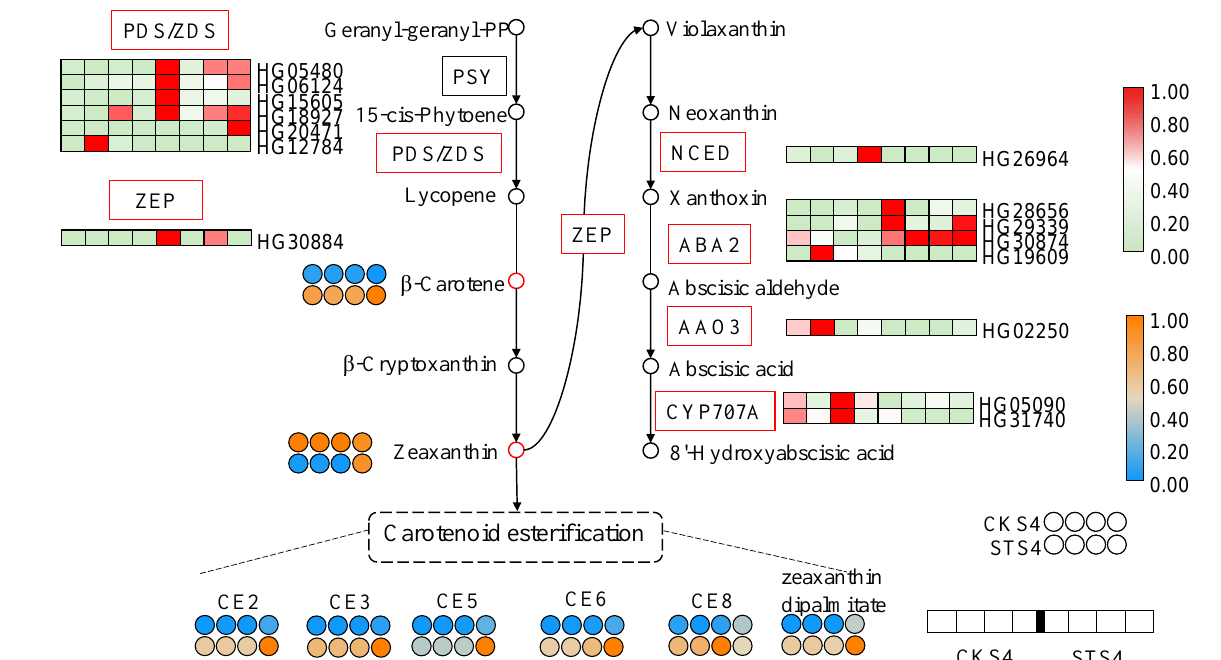
Figure 6. Differentially expressed genes (DEGs) and accumulated metabolites (DAMs) related to carotenoid biosynthesis and metabolism. Rectangle and circle cells indicate the DEG and DAM, respectively. The color key indicates that the transcript levels from low to high are represented from light green to red, and that the metabolite content from low to high are represented from blue to orange. CKS4 and STS4 are S4 fruits without and with 300 mM of salt stress treatment. PSY, phytoene synthase; PDS/ZDS, phytoene/zeta-carotene desaturase; ZEP, zeaxanthin epoxidase; NCED, 9-cis-epoxycarotenoid dioxygenase; ABA2, xanthoxin dehydrogenase; AAO3, abscisic-aldehyde oxidase.